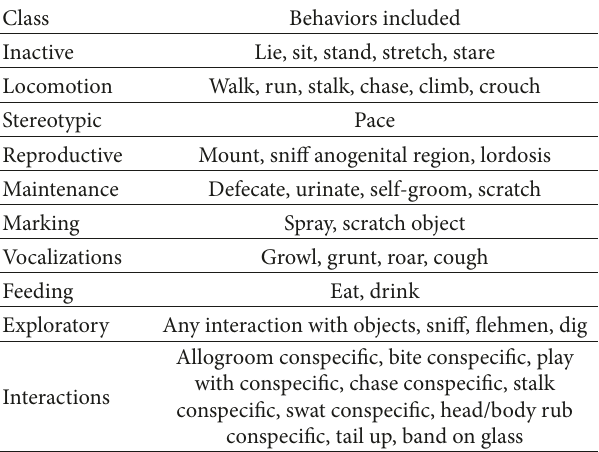
Table 2: Behavioral classes used to create time budgets. Individual behaviors come from the full ethogram, included in Table